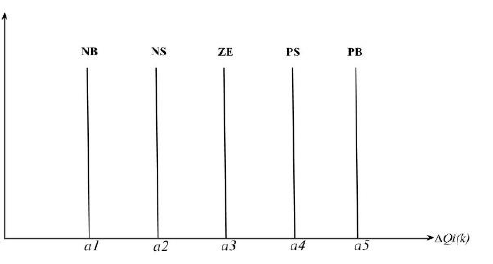
Figure 3. The fuzzifier membership function of the traditional fuzzy controller ( e i ( k ) and ∆ e i ( k ) ).